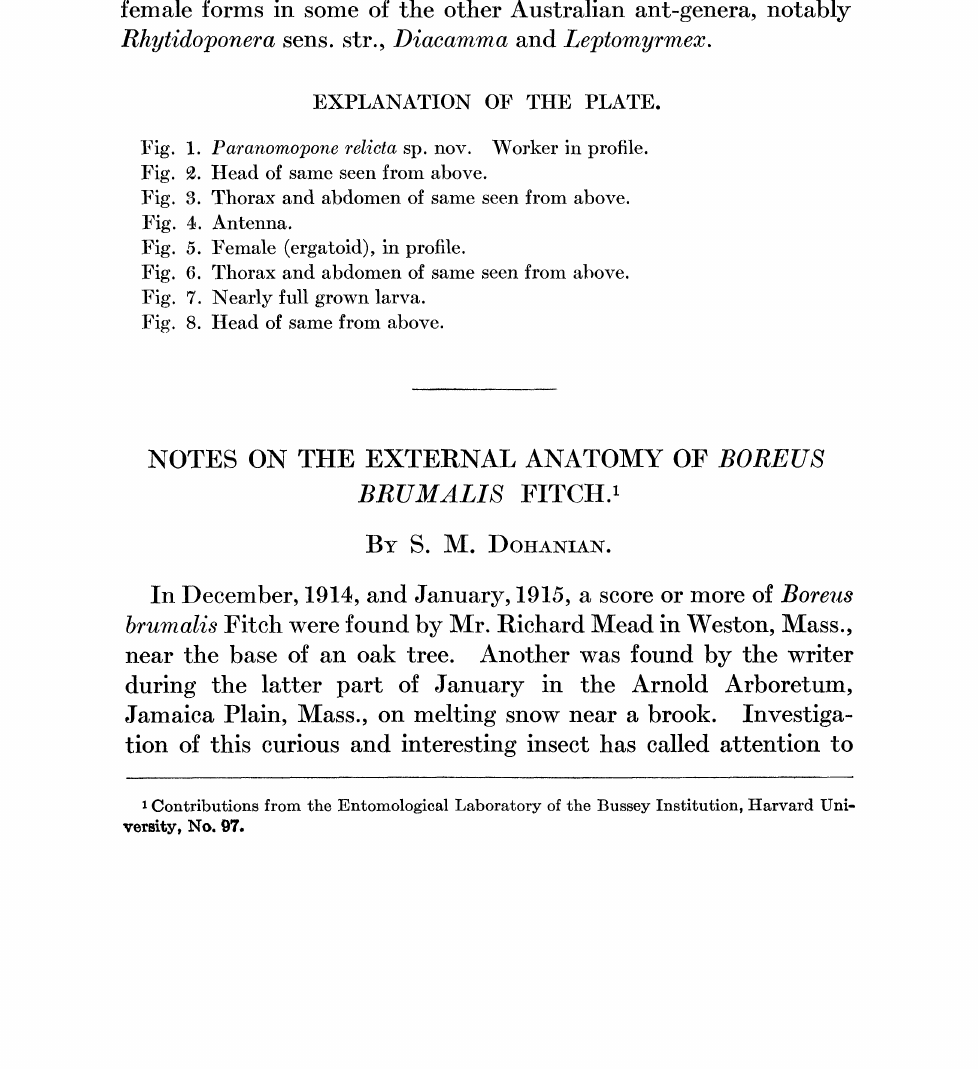
. Fig. 1. Paranomopone relicta sp. nov. Worker in profile. Head of same seen from above. Fig. Fig. 3. Thorax and abdomen of same seen from above. Fig. 4. Antenna. Fig. 5. Female (ergatoid), in profile. Fig. 6. Thorax and abdomen of same seen from above. Fig. 7. Nearly full grown larva. Fig. 8. Head of same from